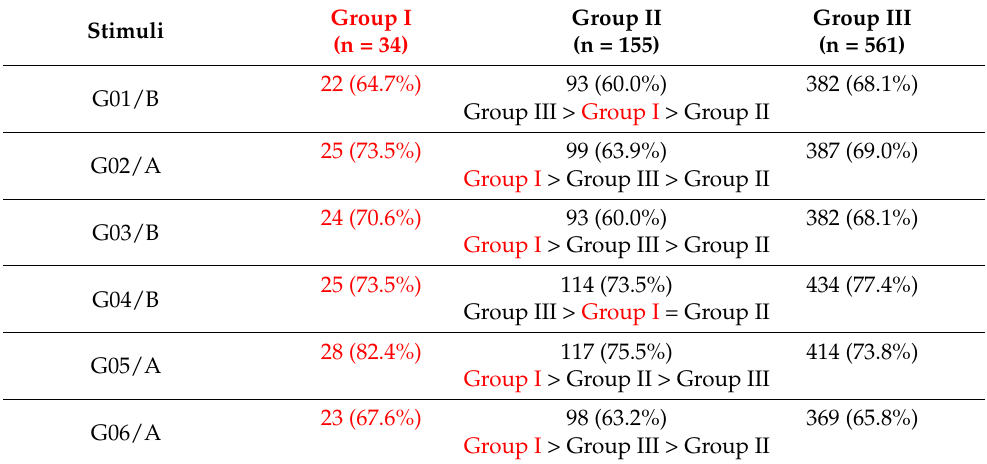
Table 4. The accuracy of the stimuli (G01–G06) was judged by the three groups based on “intuition”. Stimuli